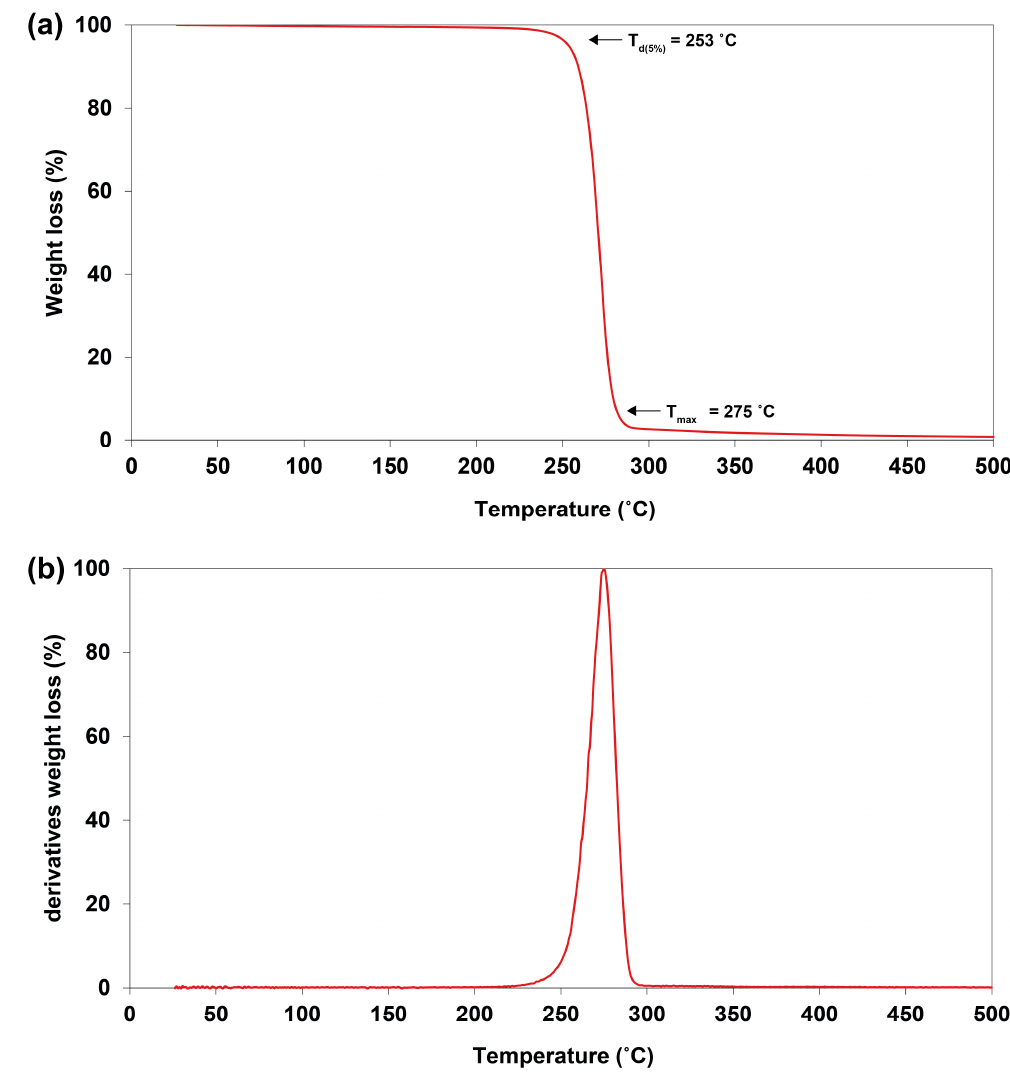
Figure 11. Thermogravimetric analysis (TGA) of PHBV from Cyanosarcina sp. AARL T020: ( a ) the weight loss curve; T d(5%) , the temperature at 5% weight loss; T max , the maximum degradation temperature; ( b ) derivatives of the weight loss curves .